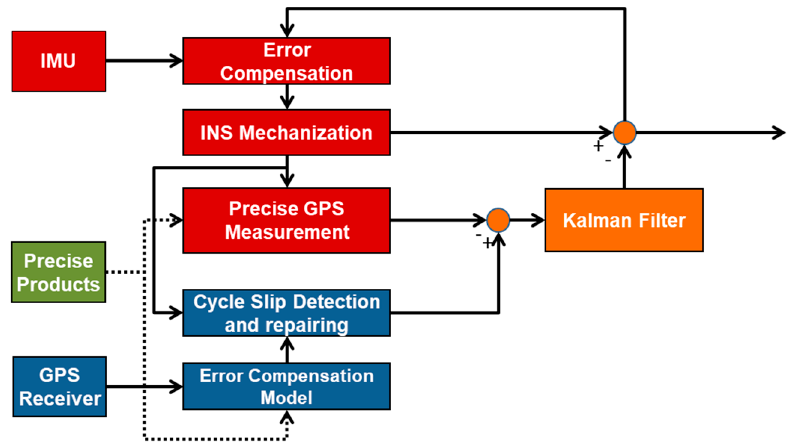
Figure 1. Architecture of Precise Point Positioning/Inertial Navigation System (PPP/INS) tightly integrated system.